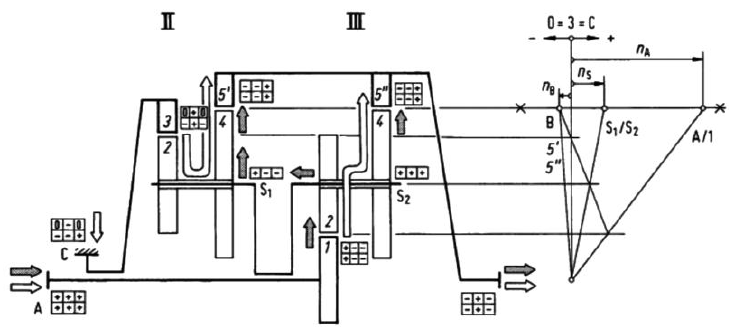
ffi ciency scheme of the Wolfrom stage Figure 5. Equivalent efficiency scheme of the Wolfrom stage gearbox. Figure 5. Equivalent e